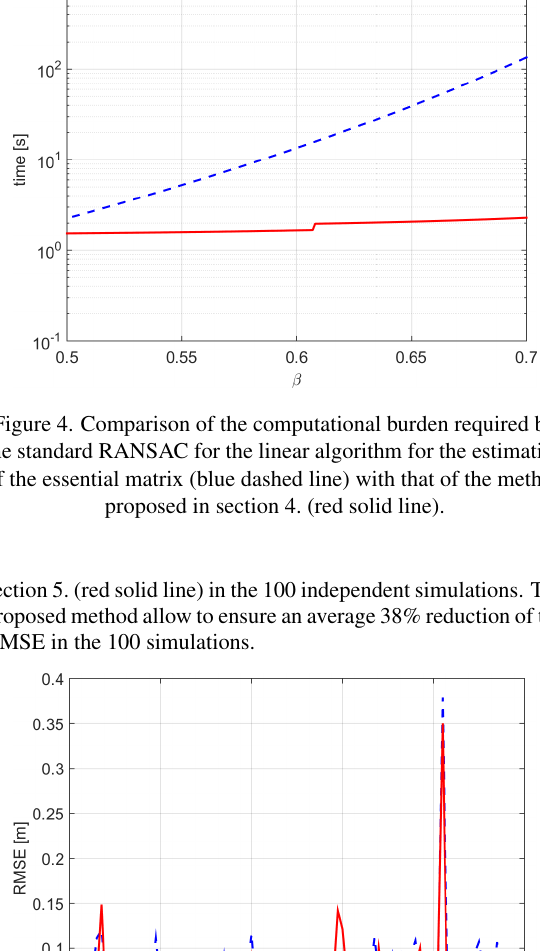
Figure 5. Comparison of the RMSE of the standard bundle adjustment (blue dashed line) with that proposed in section 5. (red solid line). The reported RMS errors have been computed in 100 independent